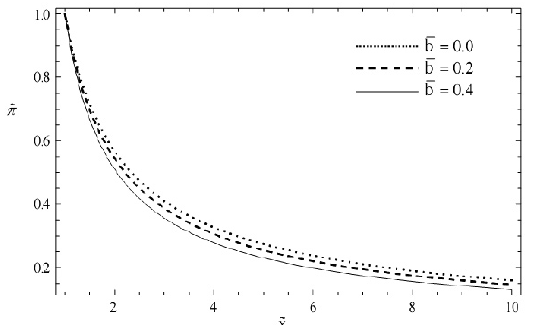
Figure 4. The decay behavior of shock strength ( ˜ π ) for m = 1 , ω = ¯ b = 0 . 2 and γ =